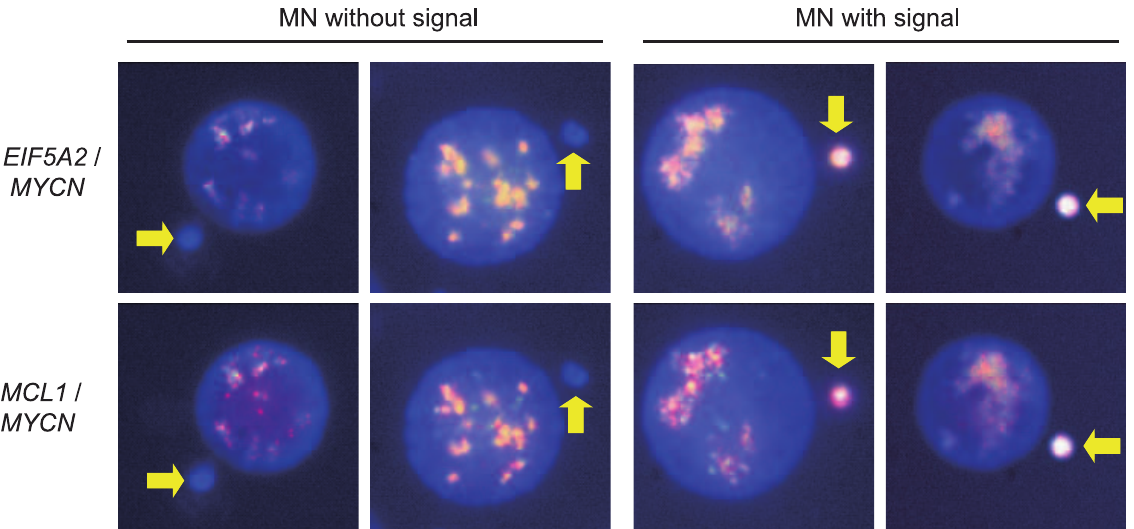
Figure 4. Entrapment of EIF5A2,MYCN and MCL1 in MN in UACC-1598 ovarian cancer cell line by growth in HU and GEM. The left two panels are representative pictures of cells showing MN without signal and the right two panels are representative pictures of cells showing MN with EIF5A2 / MYCN or MCL1 / MYCN signal. MYCN signal is shown in green, EIF5A2 and MCL1 are shown in red, and the overlap is shown in yellow. Arrows indicate MN.